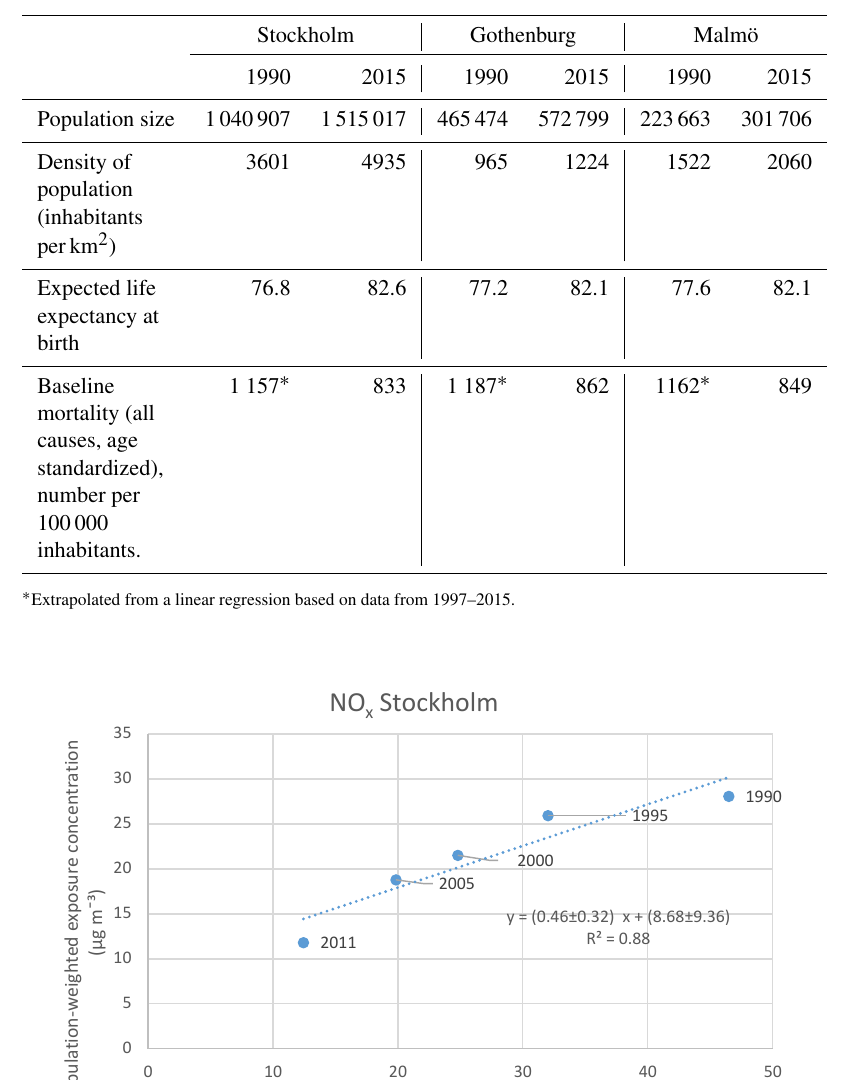
Table A1. General facts about the three cities regarding population structure, life expectancy at birth, and baseline mortality in terms of the number of deaths per 100000 inhabitants. The number of deaths per 100000 inhabitants is age standardized according to the average population for the year 2000.